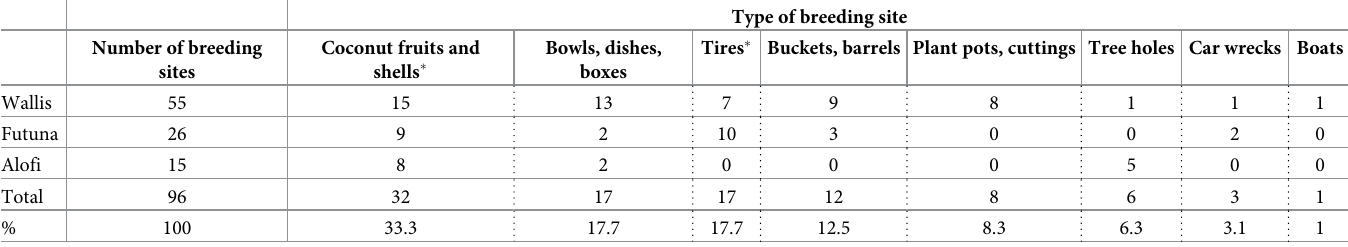
Type of breeding site